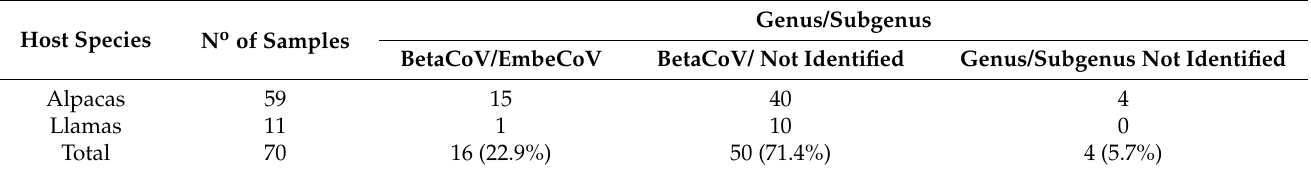
Table 3. Identification of genus Betacoronavirus and subgenus Embecovirus in alpacas and llamas. Genus/Subgenus Host Species N o of Samples BetaCoV/EmbeCoV BetaCoV/ Not Identified Genus/Subgenus Not Identified Alpacas